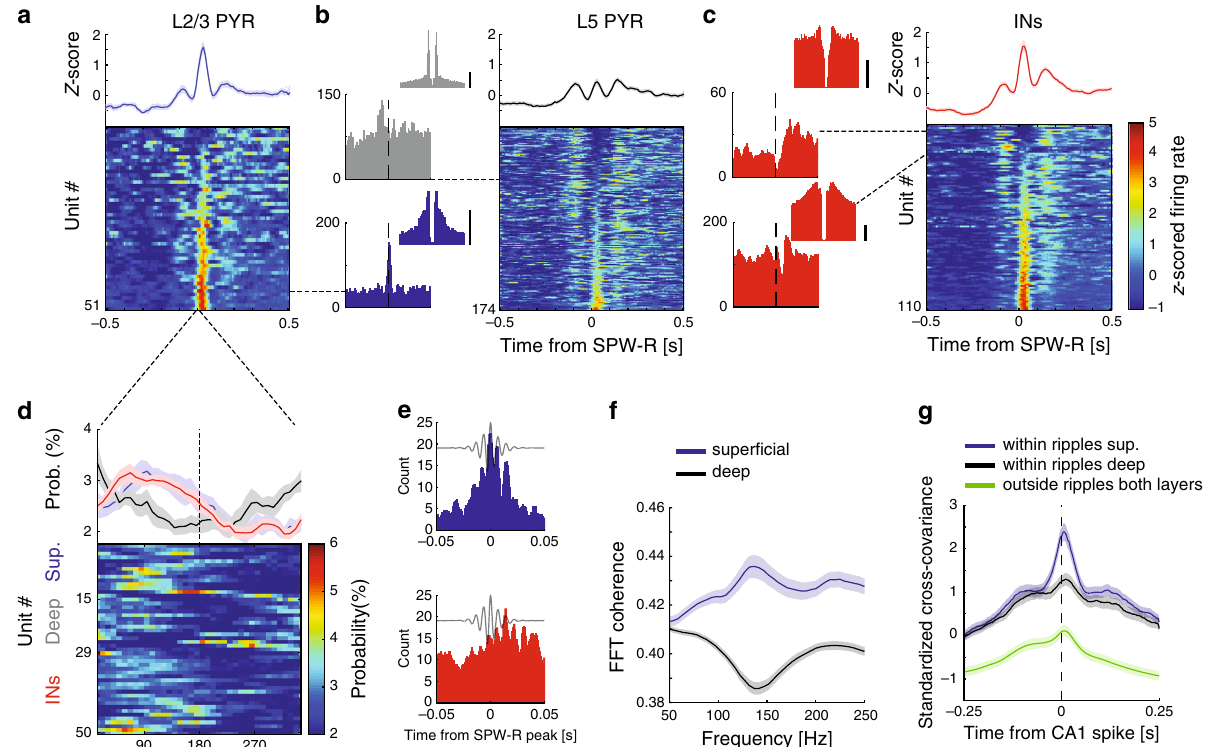
Fig. 3 Modulation of gRSC units by hippocampal SPW-Rs is layer and cell-type dependent. a – c Z-score normalized PETHs showing the average (mean ± s.e.m; top) and individual (bottom) responses of super fi cial pyramidal neurons ( a ), deep pyramidal neurons ( b ) and interneurons ( c ) sorted based on ripple modulation ( n = 27 sessions from eight mice). Dashed lines point one example PETH and the corresponding ACG (±25 ms). Scale bars, 10 Hz; Y -axis: spike count. d Average (top) and color-coded histograms (bottom) of preferred CA1 ripple phase of super fi cial pyramids (blue, top rows), deep pyramids (gray, middle rows) and INs (red, bottom rows) that are signi fi cantly phase-modulated based on circular Rayleigh test (super fi cial pyramids 15/51 = 29%; deep pyramids 14/174 = 8%; INs 21/110 = 19%). e High resolution CA1 SPW-R triggered PETH of an example super fi cial unit (top, blue) and an IN (bottom, red) signi fi cantly modulated by individual CA1 ripple waves. f Average spike-LFP coherence between super fi cial (blue) and deep (black) units and CA1 LFP (±100ms around SPW-R peak) showing a strong tuning of super fi cial, but not deep, cells to the ripple band ( n = 27 sessions from eight animals). g Standardized cross-covariance during SPW-Rs averaged over pairs of super fi cial (black) and deep (red) gRSC units fi ring within and outside of SPW-Rs epochs (green, averaged across both layers) ( n = 27 sessions from eight animals; 209 CA1 – super fi cial gRSC pairs, 351 CA1 – deep gRSC pairs and 560 CA1 – gRSC units outside ripples). See Supplementary Fig.